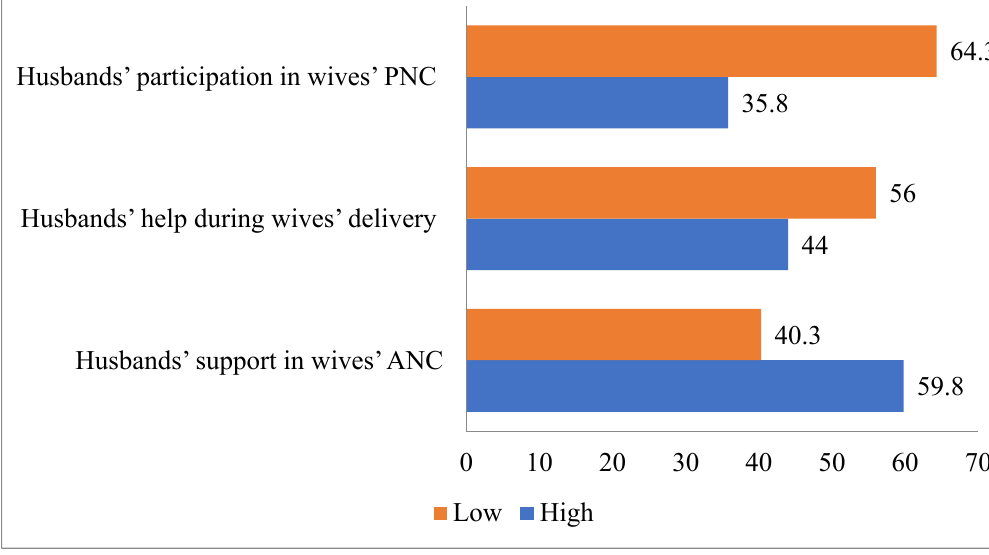
Figure 2. Distribution of women’s perception of husbands’ involvement level in maternal health care. Table 3. Distribution of wives’ perception of husbands’ support in different aspects of ANC,